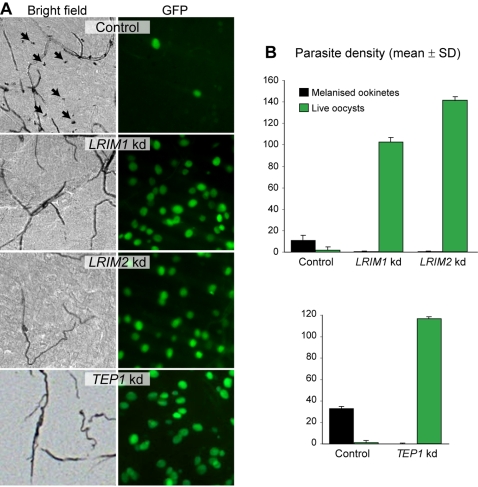
Silencing LRIM1, LRIM2 and TEP1 transforms An. quadriannulatus into a vector species.(A) Representative microscopy images of midguts dissected from P. berghei-infected mosquitoes which were injected with either LacZ dsRNA (control) or dsRNAs for each of the examined genes. GFP-fluorescent oocysts are shown in the right panels whereas arrows in the bright field images indicate melanized ookinetes. No melanized ookinetes and higher oocyst densities are observed in kd mosquitoes. (B) Quantitative effects of gene kds on melanized ookinete density (black bars) and oocyst density (green bars) in mosquito midguts compared to LacZ dsRNA-treated controls. The pooled results from two independent experiments were analyzed using the REML variance component analysis by fitting the mixed effects model. Geometric means and standard deviations are shown. Experiments with LRIM1 and LRIM2 kds were performed separately from those with TEP1 kd; thus they are presented in separate graphs.